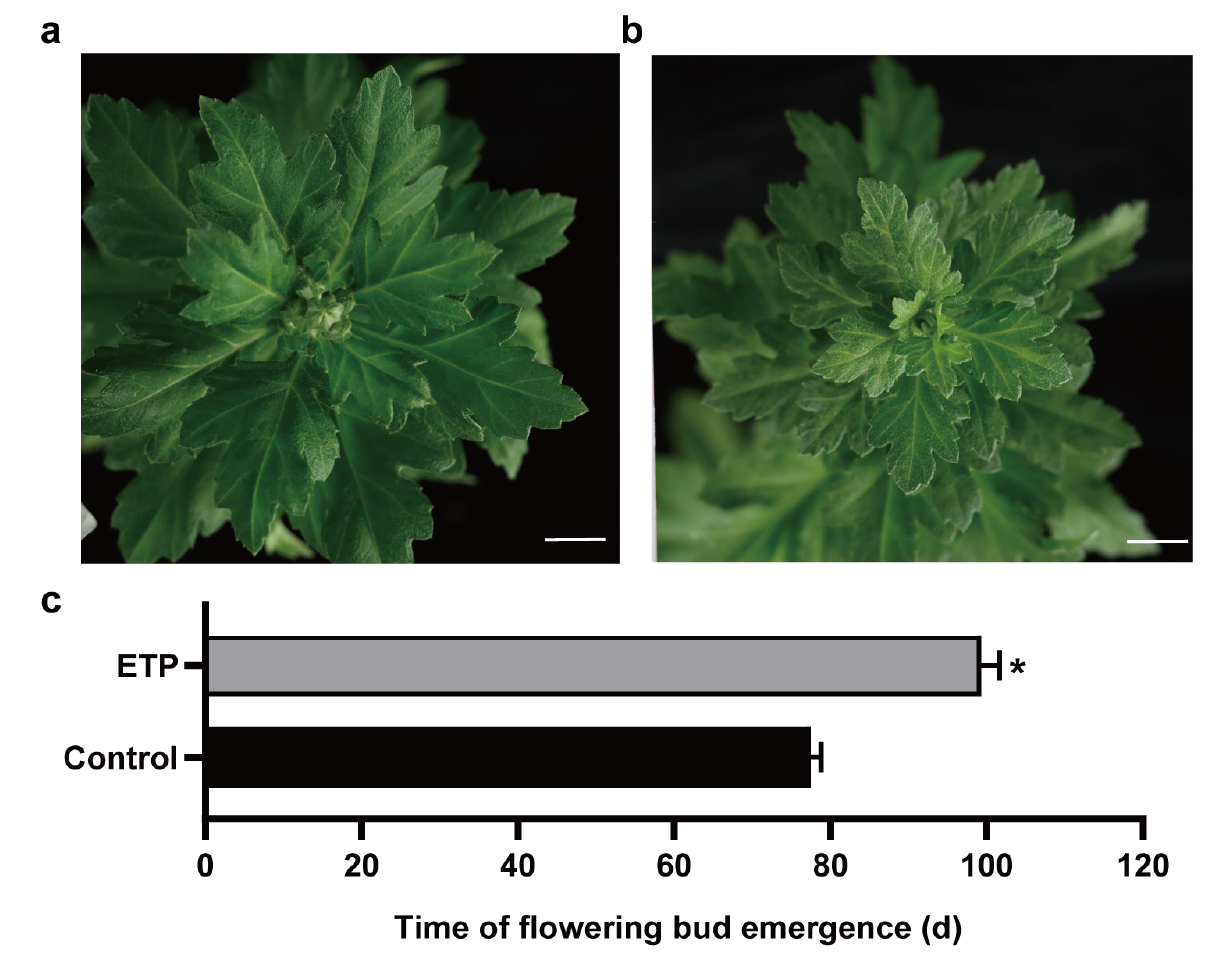
Figure 1. Phenotypes of wild type chrysanthemum ‘Jinba’ following water and ethephon treatment. Phenotypes of wild type chrysanthemum ‘Jinba’ treated with water ( a ) and ethephon ( b ) at 79 days after plantation. Bar = 1 cm. ( c ) Statistics of the time of flowering bud emergence. Student’s t -test was used to verify significant differences (* p < 0.05); n = 57. Error bars indicate standard deviation (SD).